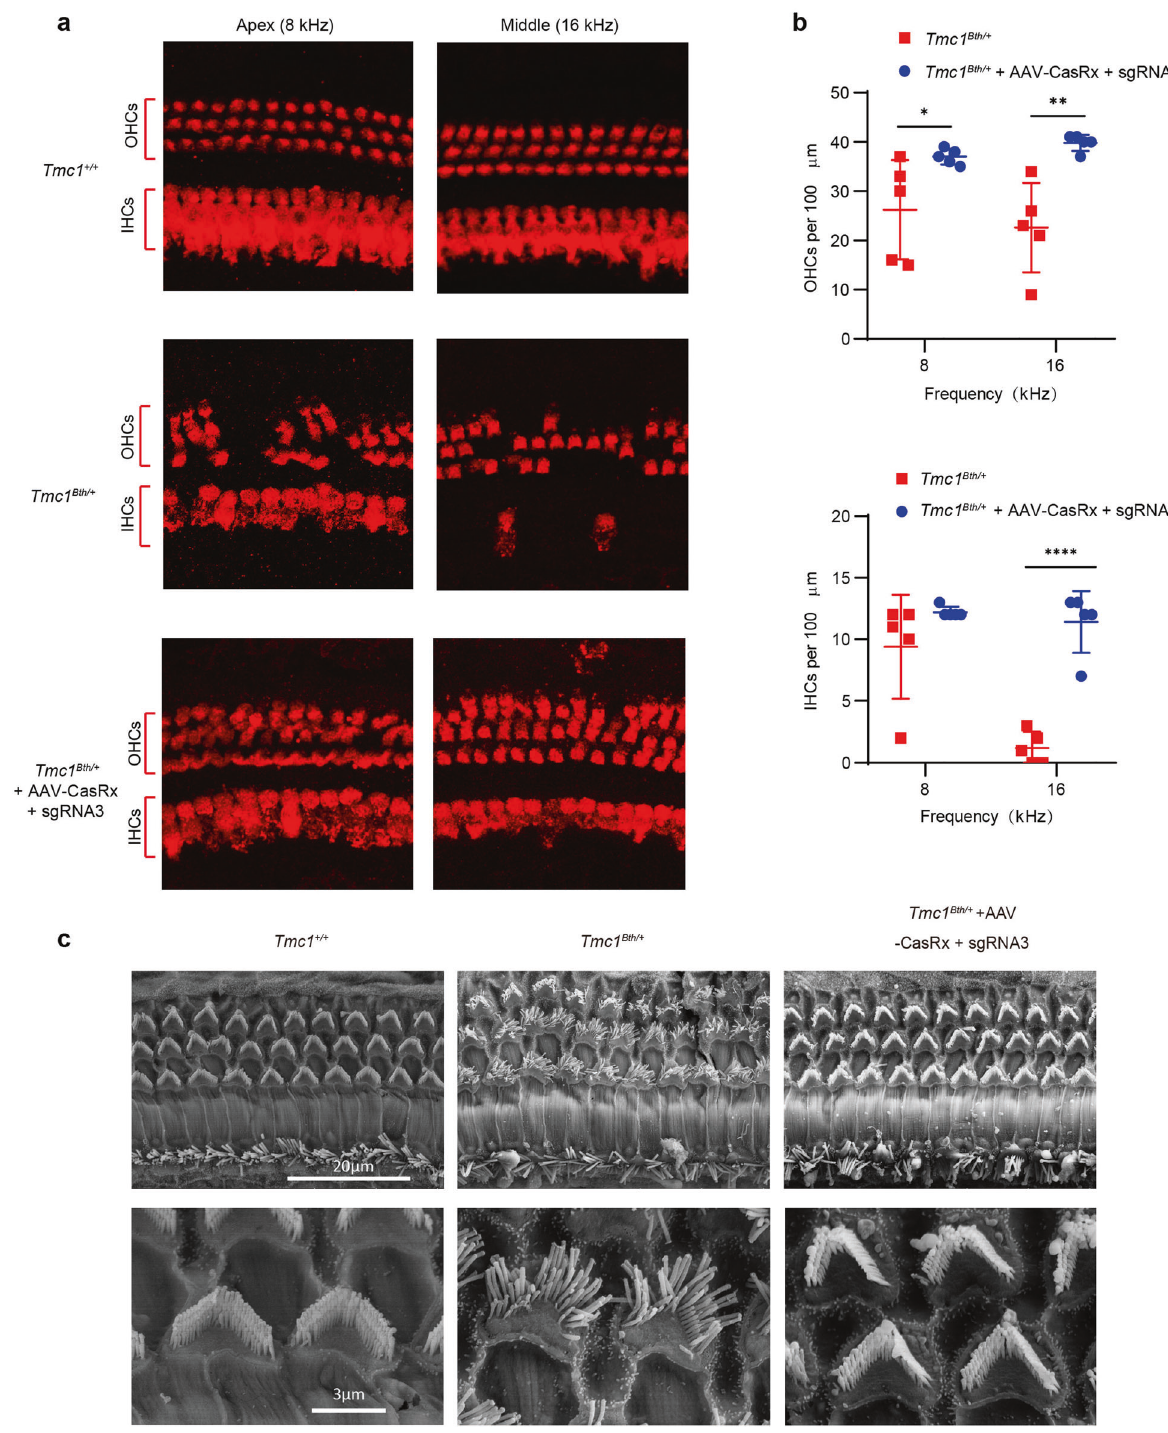
Fig. 5 Injection of AAV-CasRx + sgRNA3 (~5 × 10 9 vg of AAV) protects hair cells and hair bundles. a Representative confocal images of 100 μ m cochlear sections harvested 10 weeks after injection. Samples were stained with myosin7a (Red). The images are from Tmc1 + / + , Tmc1 Bth/ + + AAV-CasRx + sgRNA3, and Tmc1 Bth/ + non-injected mice ( n = 5 mice) at locations corresponding to 8 and 16 kHz. The IHCs and OHCs are indicated. Scale bar: 20 μ m. b The number of OHCs (upper) and IHCs (lower) per 100 μ m of the cochleae. Data are shown as the mean ± SD, *p < 0.05, **p < 0.01, ***p < 0.001, and ****p < 0.0001. Statistical analysis was performed by two-way Sidak ’ s multiple comparisons test. c SEM images of the apical cochlear sensory epithelium showing the morphology of the hair cell bundles. Tmc1 + / + , Tmc1 Bth/ + + AAV-CasRx + sgRNA3, and Tmc1 Bth/ + non-injected samples were collected 10 weeks after injection. Scale bars: 20 μ m (upper); 3 μ m (lower)